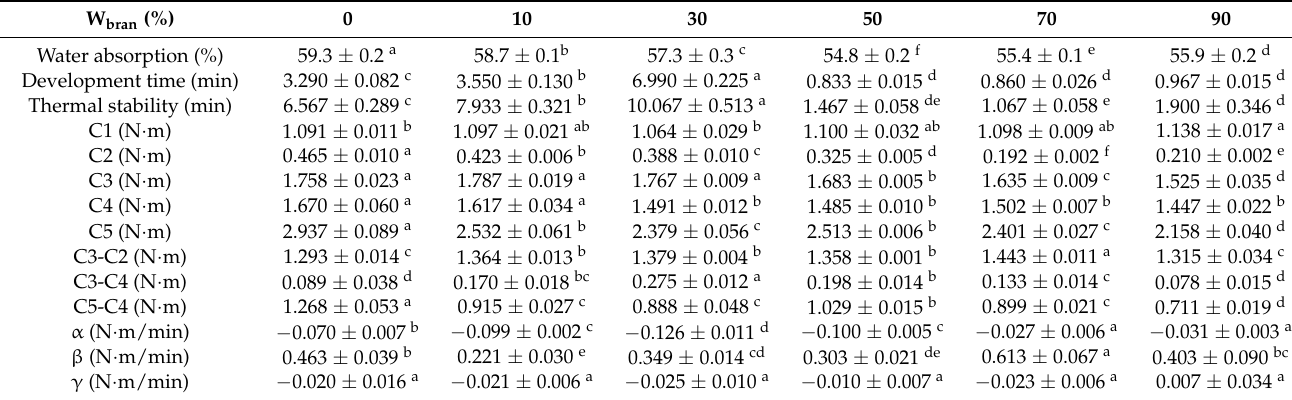
Figure 5. Effect of W bran on the mixolab curves of mixed dough (TBF: Tartary buckwheat flour; TBCF: Tartary buckwheat core flour; TBBF: Tartary buckwheat bran flour; W bran : the weight proportion of TBBF in the blend four). Table 5. Effect of W bran on parameters values of Mixolab curves of mixed dough.